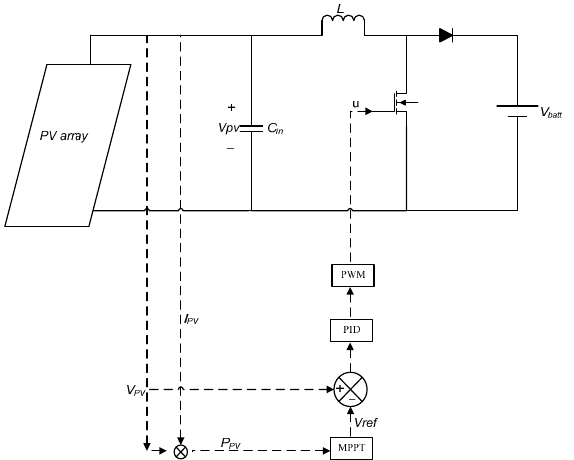
Figure 1. System scheme based on a classical proportional integral derivative (PID) control.